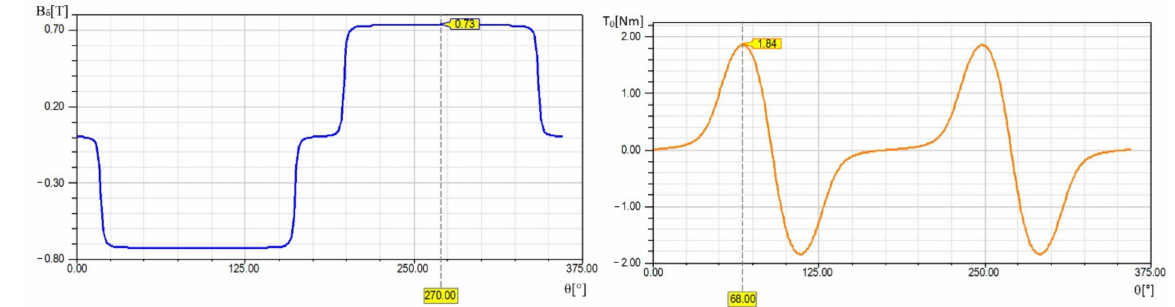
Figure 5. The magnetic flux density in air gap δ 1 as a function of the rotor position. The blue cursor indicates the amplitude B δ = 0.73 T ( left ); cogging torque as a function of the rotor position. The yellow cursor indicates the amplitude T 0 = 1.84 Nm ( right ).